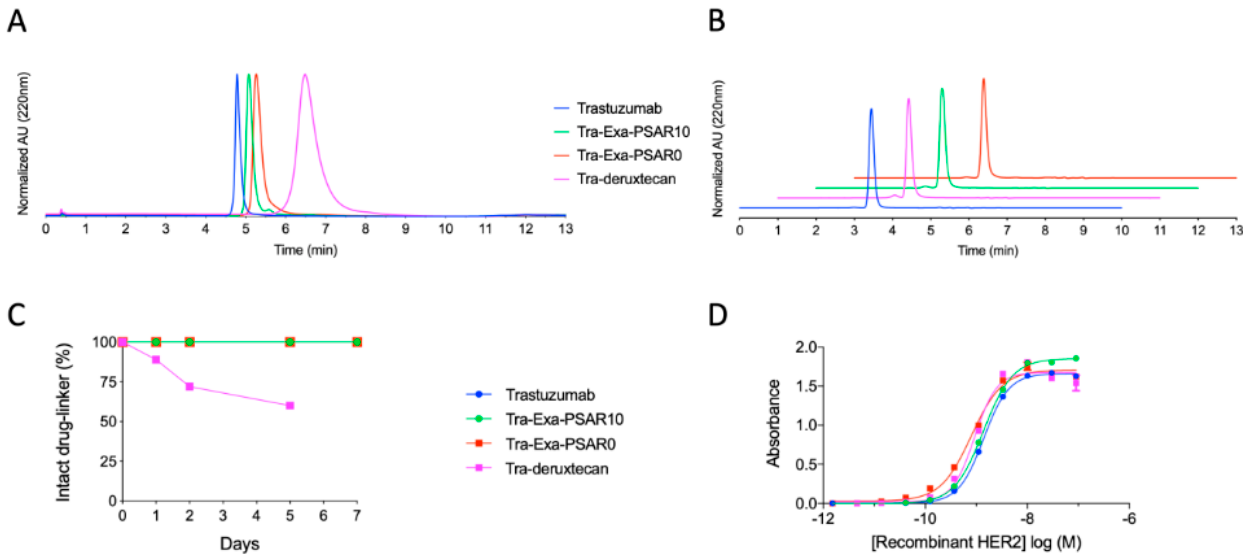
Figure 2. Physicochemical characterization of ADCs. ( A ) Hydrophobic Interaction Chromatograms (HIC) of DAR8 ADCs. ( B ) Size Exclusion Chromatograms (SEC) of DAR8 ADCs. ( C ) Ex-vivo rat plasma stability studies, as assayed by immunocapture and reversed phase HPLC—mass spectrometry. Low immunocapture recovery of the heavy-chain of the Tra-deruxtecan conjugate prevented us to report stability data at day 7 for this ADC. ( D ) HER2 ELISA binding affinity profiles of ADCs.